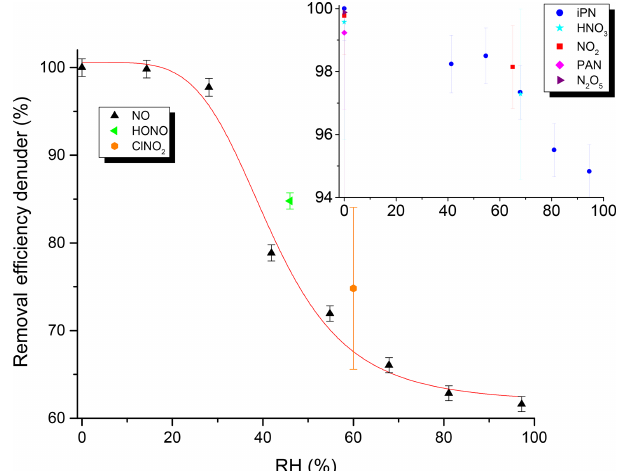
Figure 6. Removal efficiency of the denuder for various NO y trace gases as a function of RH. Units of the inset are identical to the main graph. See Table S2 for the exact values and information on the error